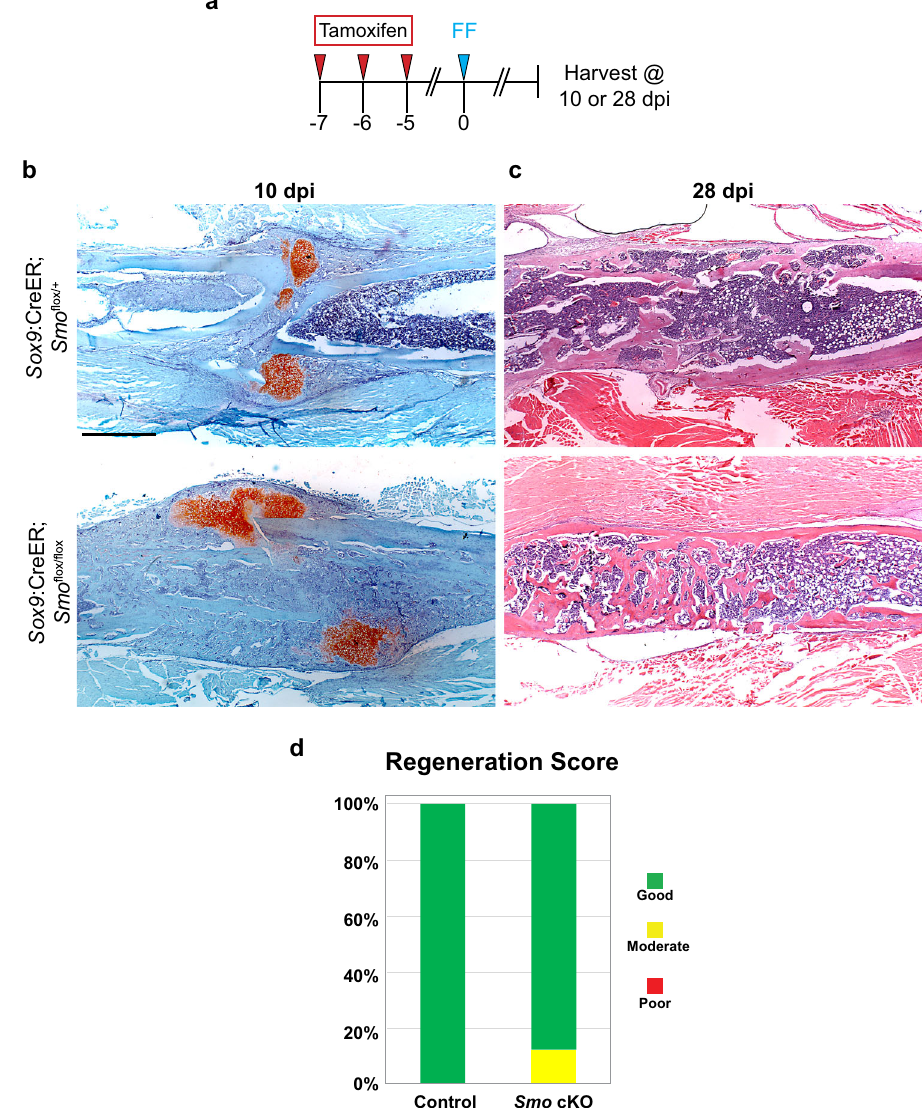
Fig. 8 Smo is not required in Sox9 + lineage cells for femur fracture repair. a To knock out Smo in Sox9 + lineage cells, animals received tamoxifen injections on days − 7, − 6, and − 5. All femur fractures were performed on day 0 and tissue was harvested at 10 or 28 dpi to assay regeneration outcomes. b Safranin-O stained histological sections at 10 dpi show that both Sox9 :CreER; Smo fl ox/ + controls and Sox9 :CreER; Smo fl ox/ fl ox Smo cKO mice generate a Safranin-O stained cartilage callus. N = 4. Scale bar = 1 mm. c H&E stained histological sections at 28 dpi. Both Sox9 :CreER; Smo fl ox/ + controls and Sox9 :CreER; Smo fl ox/ fl ox Smo cKO mice exhibit an injury sited bridged with bone. N = 4. d Blinded scoring of regeneration outcomes. Safranin-O (10 dpi) and H&E (28 dpi) stained sections were both used to score each animal ’ s regeneration outcome as Good, Moderate, or Poor (see Methods for details). Control ( Sox9 :CreER; Smo fl ox/ + ) animals all healed well and scored as Good (8/8 animals). Smo cKO ( Sox9 :CreER ;Smo fl ox/ fl ox ) animals also healed well and scored as Good (7/8 animals) or Moderate (1/8